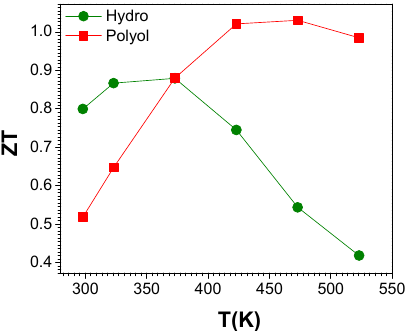
Figure 9. Temperature dependent thermoelectric (TE) figure of merit (ZT), of SPS compacted pellets for Bi 2 Te 3 materials synthesized through MW-assisted hydrothermal and polyol routes.